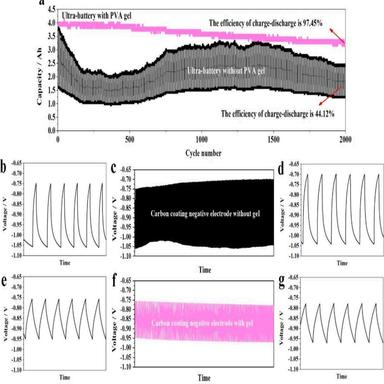
(a) the cycle life test of ultra-batteries with carbon coating negative electrodes with and without PVA gel. (b-d) the floating test of the ultra-battery with carbon coating negative electrodes without PVA gel during cycling. (e-g) the floating test of the ultra-battery with modified carbon coating negative electrodes during cycling.